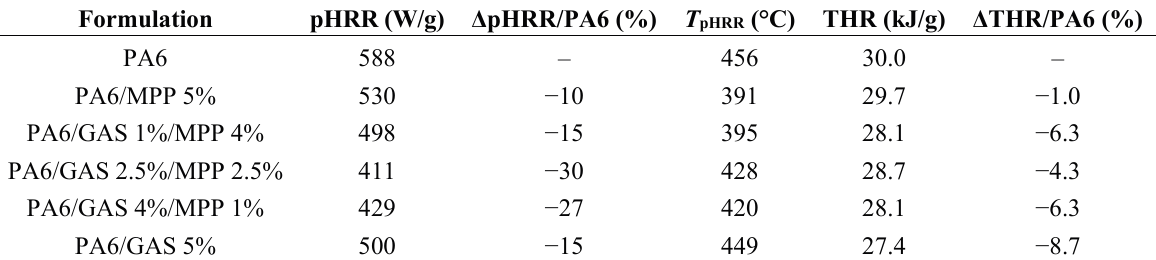
Table 3. MCC results of PA6, PA6/GAS 5% and PA6/GAS/MPP formulations. THR, total heat release.